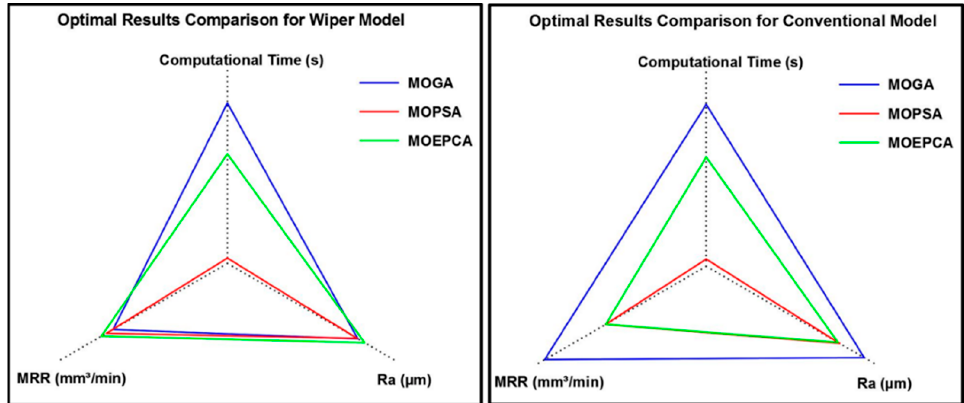
Figure 14. Comparison of optimal results between all optimization techniques for both models: wiper ( left ) and conventional ( right ).